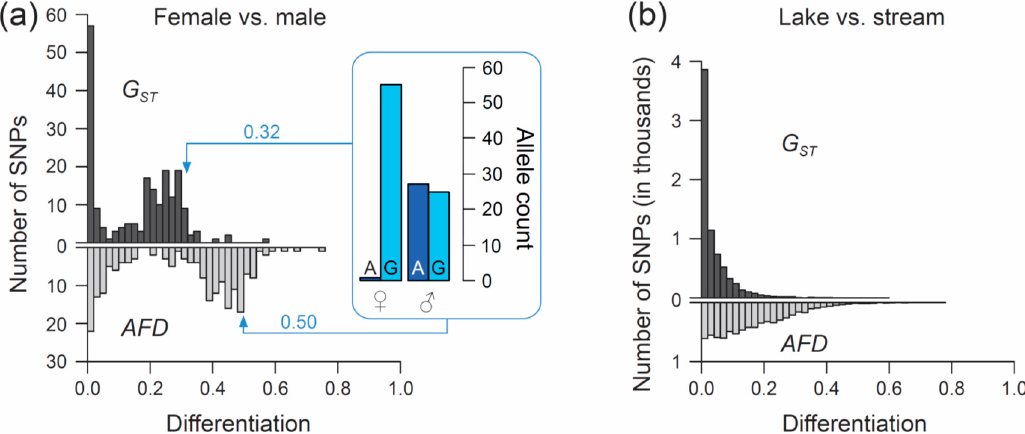
Figure 3. Performance of F ST versus AFD in empirical analyses. ( a ) Distribution of the magnitude of differentiation, as measured by the F ST estimator G ST (upper histogram) and by AFD (lower histogram), between female and male threespine stickleback across 200 SNPs located on chromosome 19. The box visualizes the sex-specific allele counts at one exemplary SNP representative of the upper mode of each distribution, with G ST and AFD for this marker given next to the arrows. ( b ) Distribution of G ST and AFD values across 7282 genome-wide SNPs in a lake and stream stickleback population comparison.